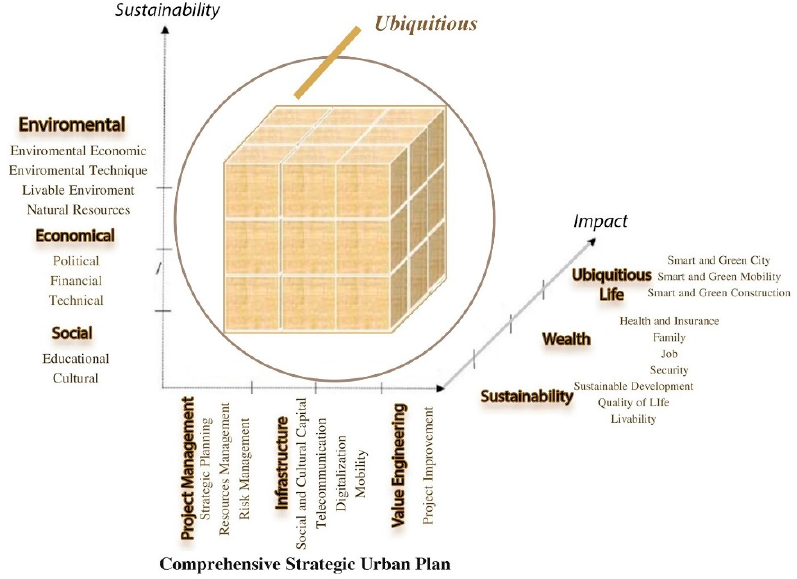
Figure 12. U-DSR Plus Theory.